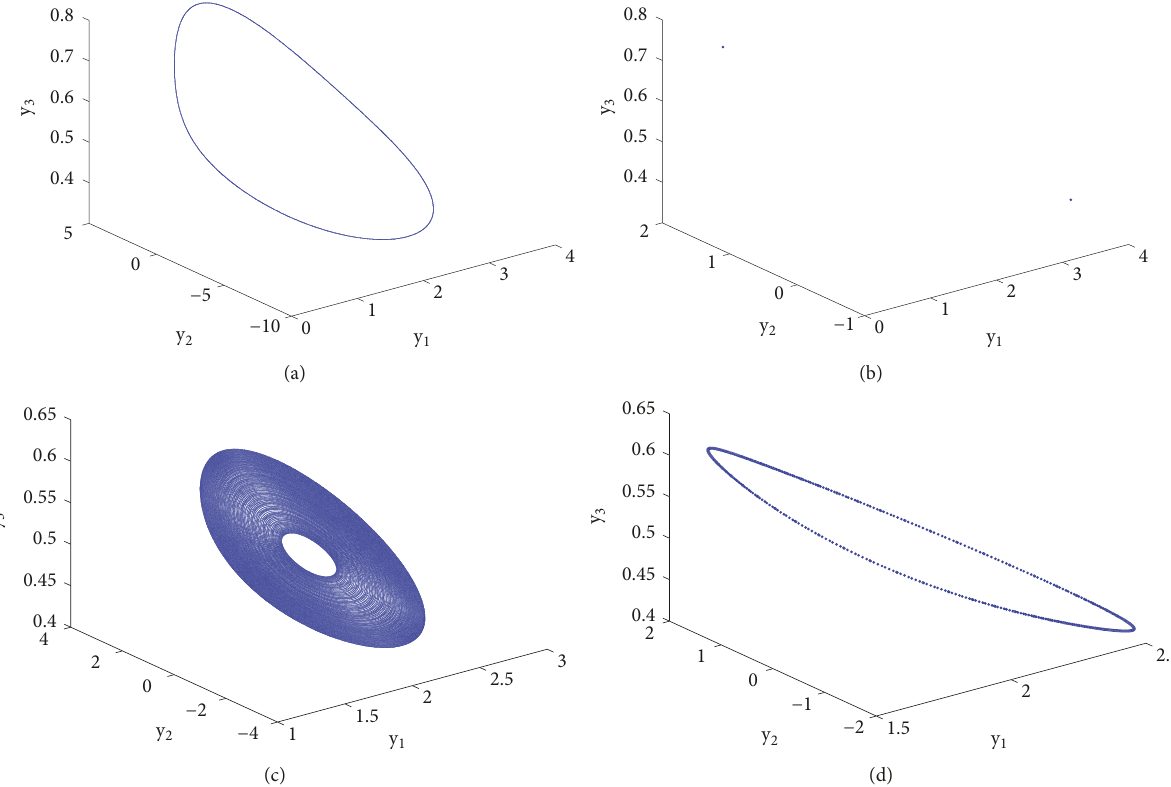
Figure 8: Phase portraits ((a), (c)) and Poincare sections ((b), (d)) are corresponding to the solutions in Figures 7(a) and 7(b), where